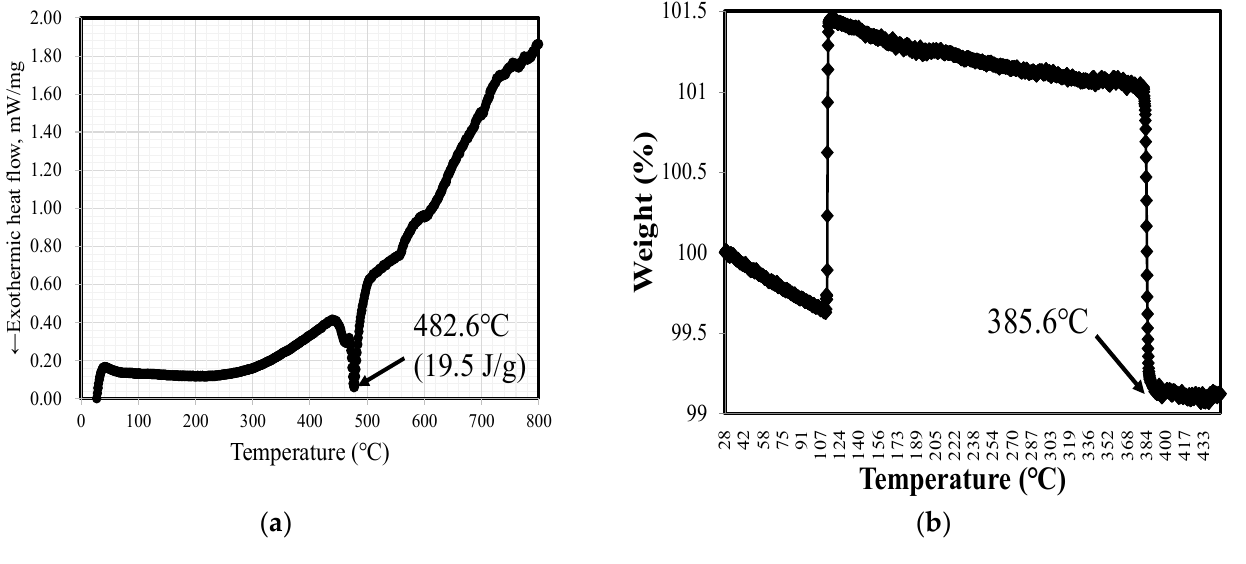
Figure 2. Magnetic properties of amorphous alloy: ( a ) exothermic heat flow by scanning calorimetry and ( b ) thermogravimetric analysis.